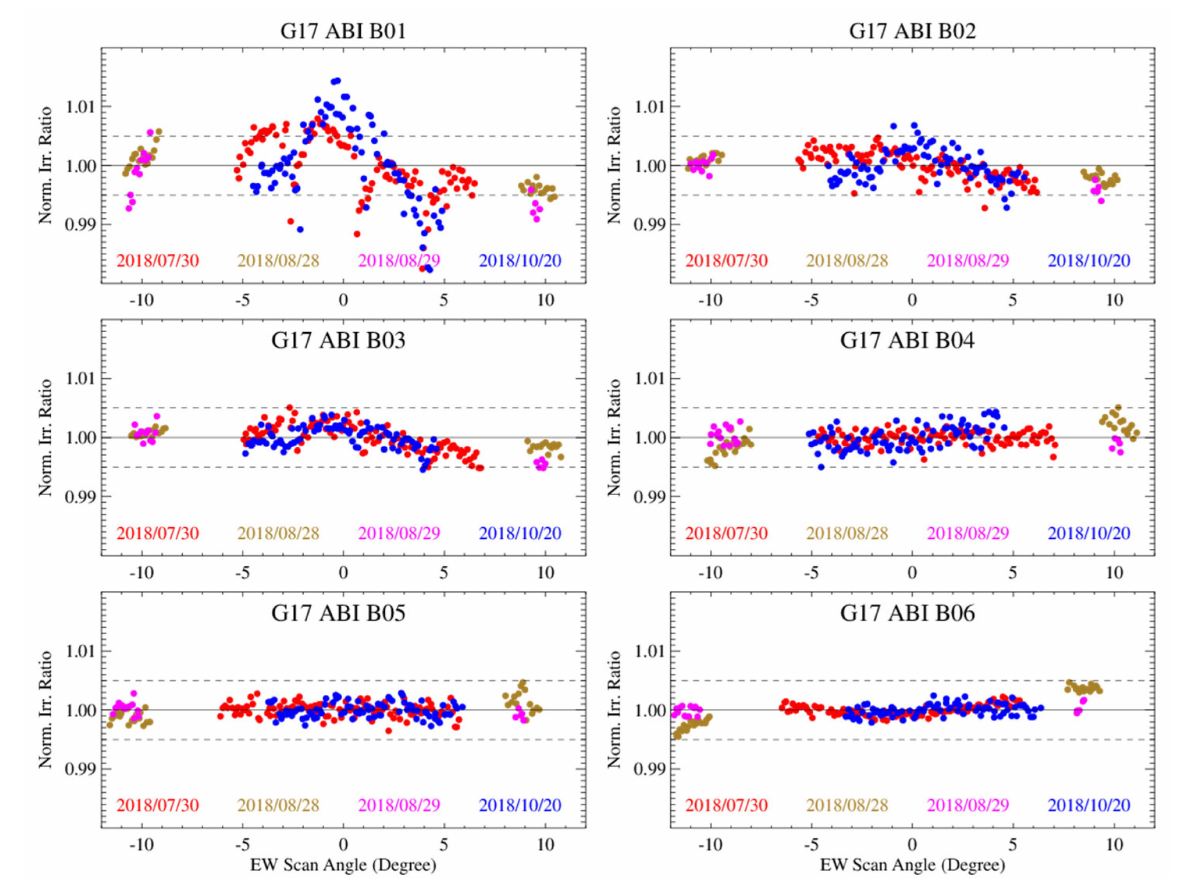
Figure 9. Same as Figure 8, but for